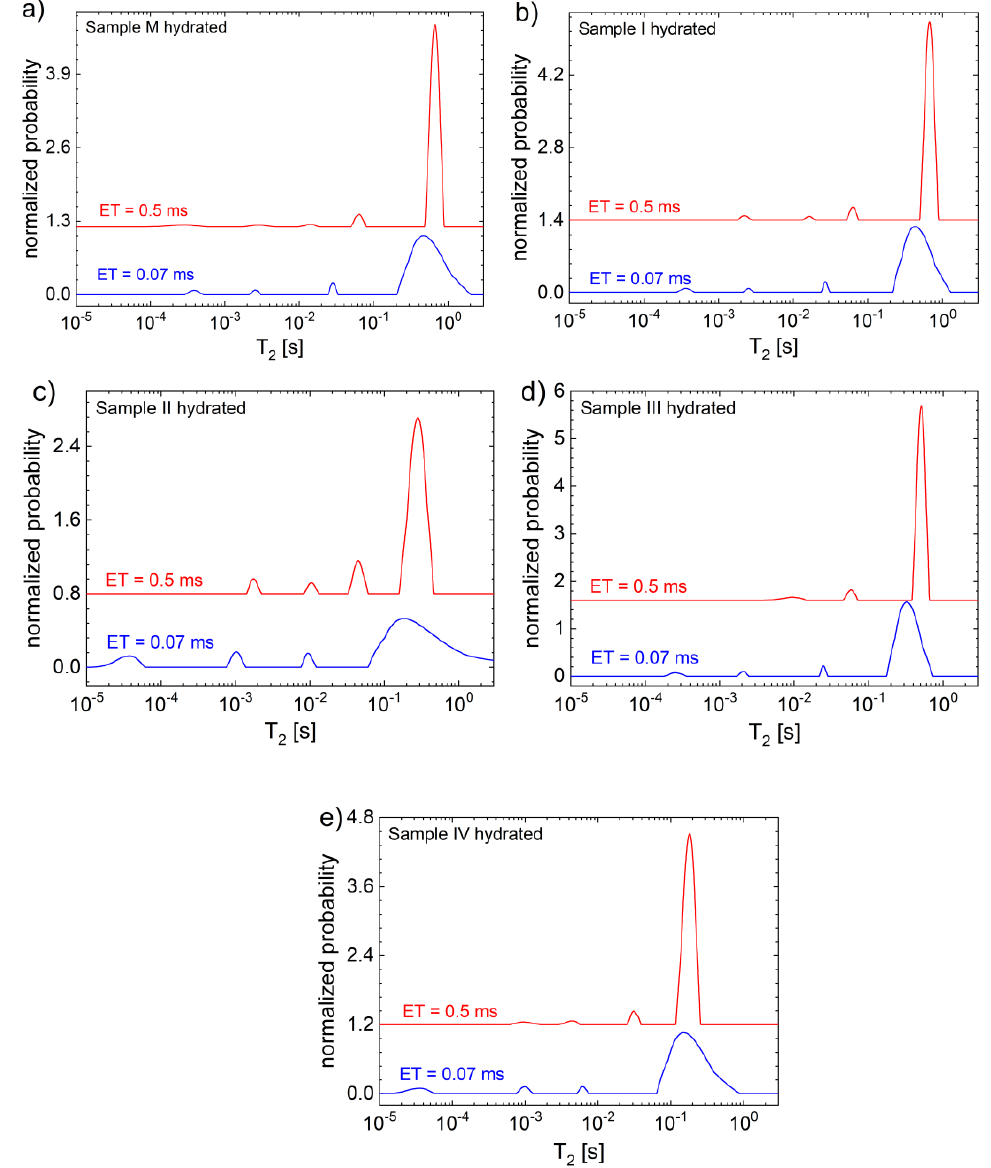
Figure 6. The T 2 distributions of hydrated hydrogel samples; ( a ) control sample M, ( b ) sample I, ( c ) sample II, ( d ) sample III, and ( e ) sample IV measured for an echo time ET = 0.07 ms (blue) and ET = 0.5 ms (red).